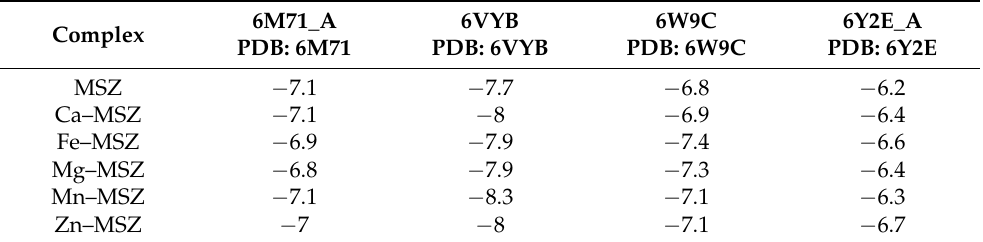
Table 1. Binding energies of Methisazone and its metal complexes for four SARS-CoV-2 proteins (best results) (kcal/mol).